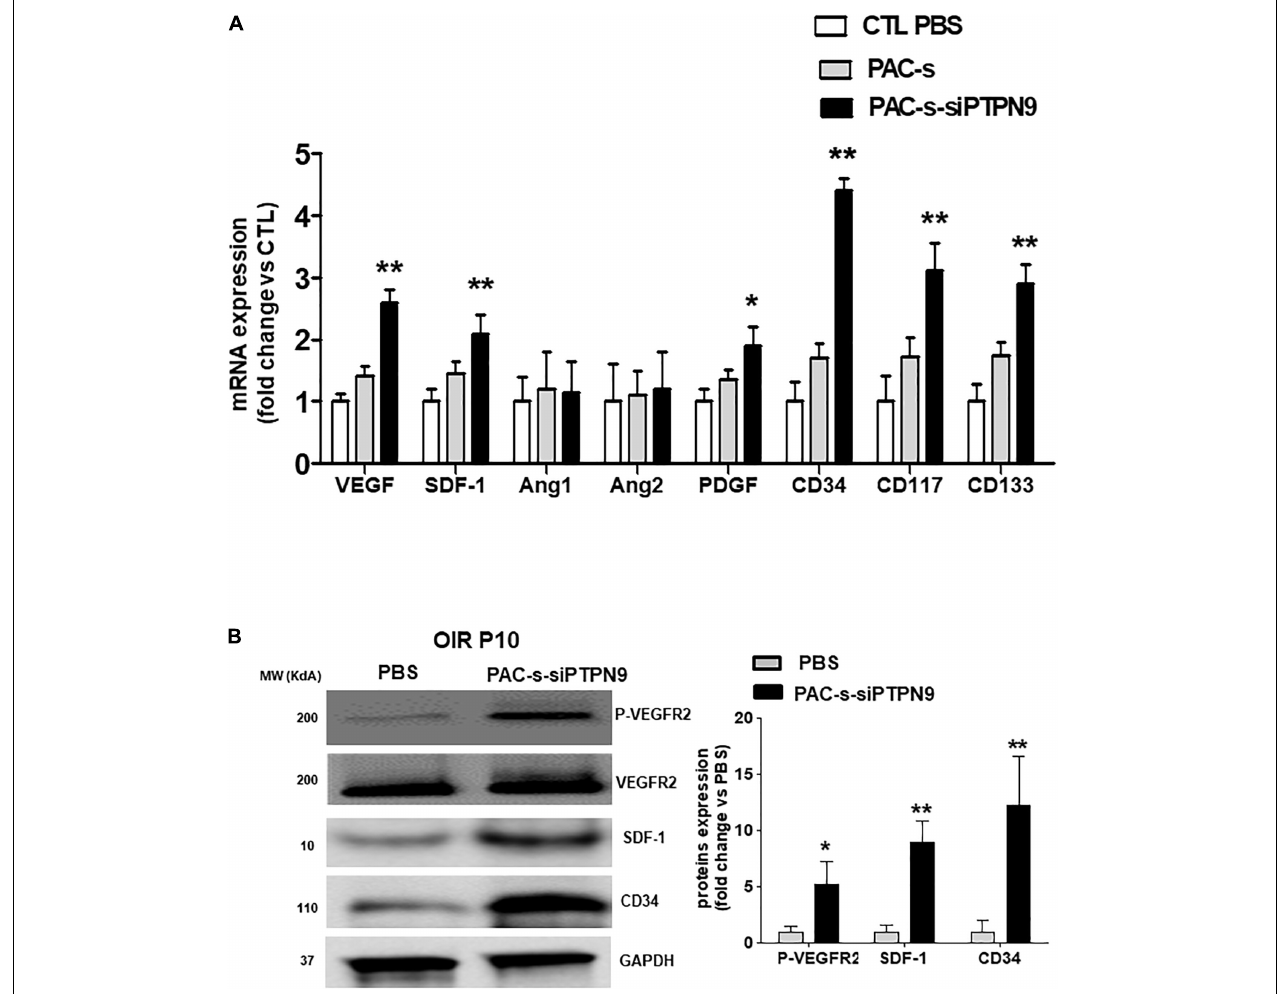
FIGURE 6 | Intraocular injection of siPTPN9-PAC-CM increases the expression level of PAC mobilization factors and stimulates angiogenic signals in the retina of OIR-subjected rats. (A) OIR-subjected rats were treated with a single intravitreal injection (1 µ l of 50 × concentrate) of PAC-s or siPTPN9-PAC-s or PBS at P5, before exposure to hyperoxia. Animals were then exposed to constant hyperoxia (80% O 2 ) until P10. (A,B) qRT-PCR (A) and western blot (B) analyses of angiogenic factors, PAC markers, and VEGFR2 activation state (P-VEGFR2) in the retina of OIR-subjected rats treated or not with PAC-s or siPTPN9-PAC-s. Data are mean ± SEM. * P < 0.05 or ** P < 0.01 vs. PBS (control). N = 4–6 retinas/group for qRT-PCR and a pool of 5 retinas for western